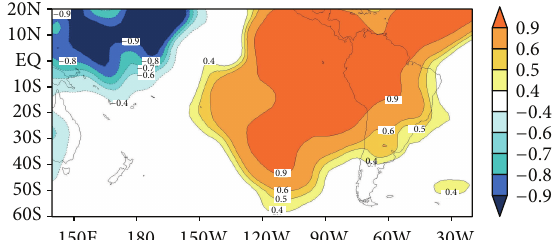
Figure 9: Composite anomalies of 200hPa velocity potential anomalies( ×10 6 m 2 s −1 ;shaded)shadedvaluesaresignificantat90% using t -test for DJF or Austral summer season for all extreme high- streamflow events associated with La